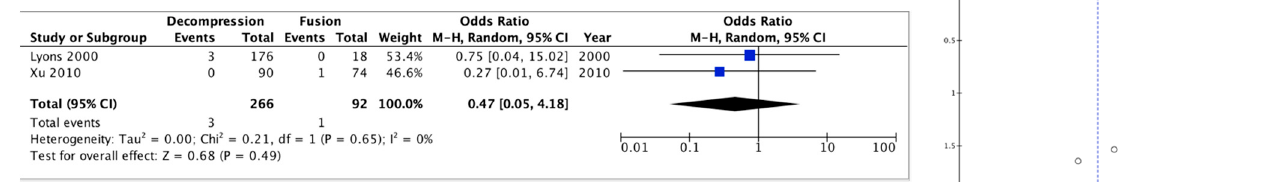
Figure A13. CSF leakage.